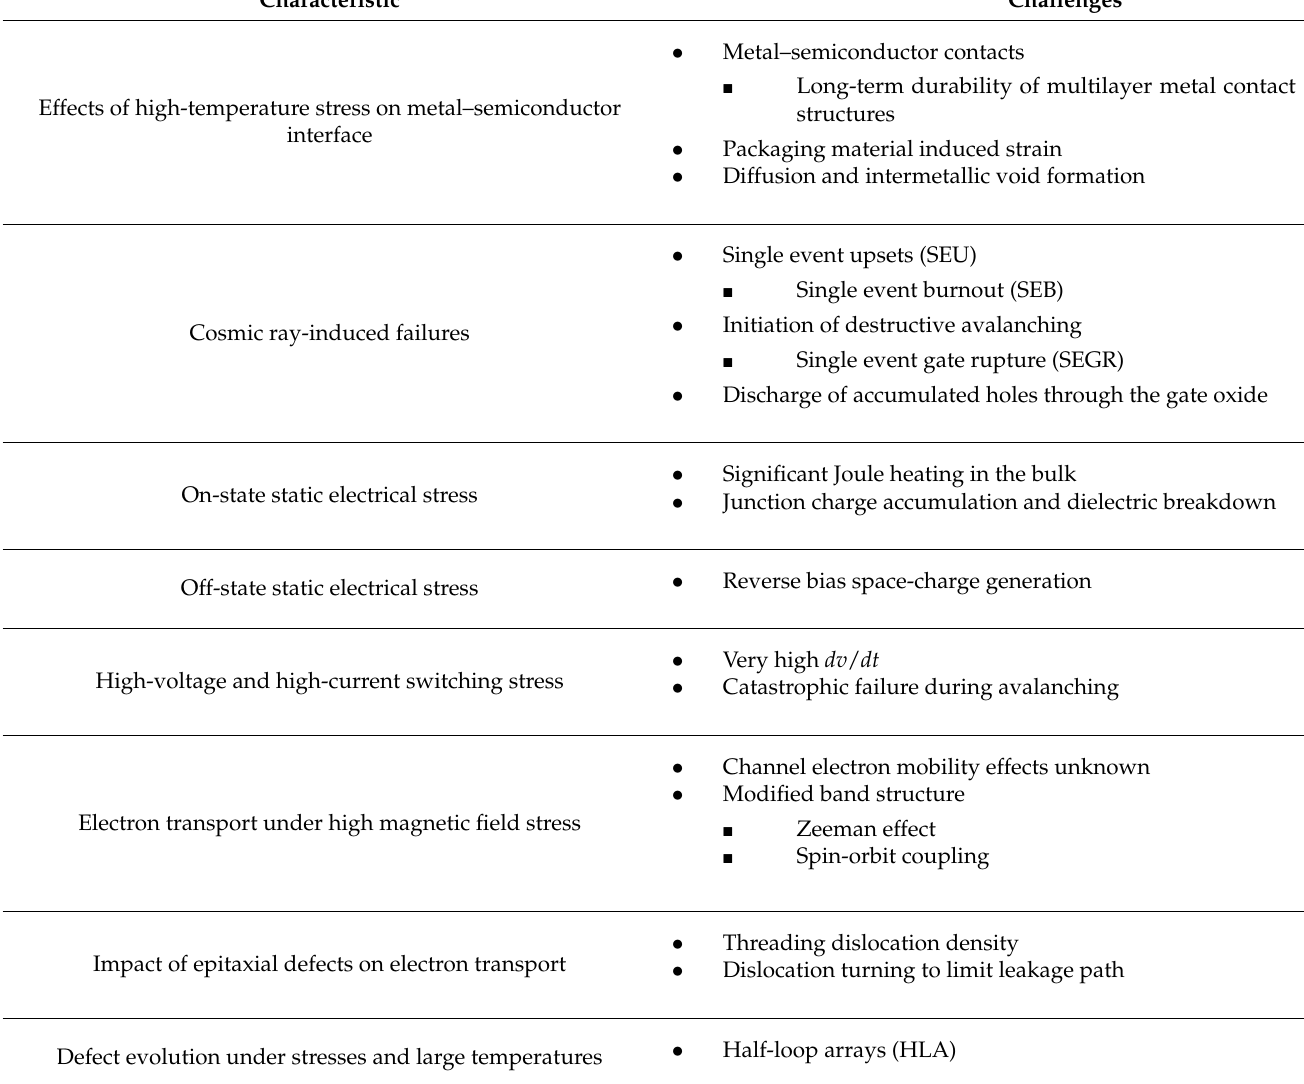
Table 1. Summary of WBG device characteristics and the challenges posed by